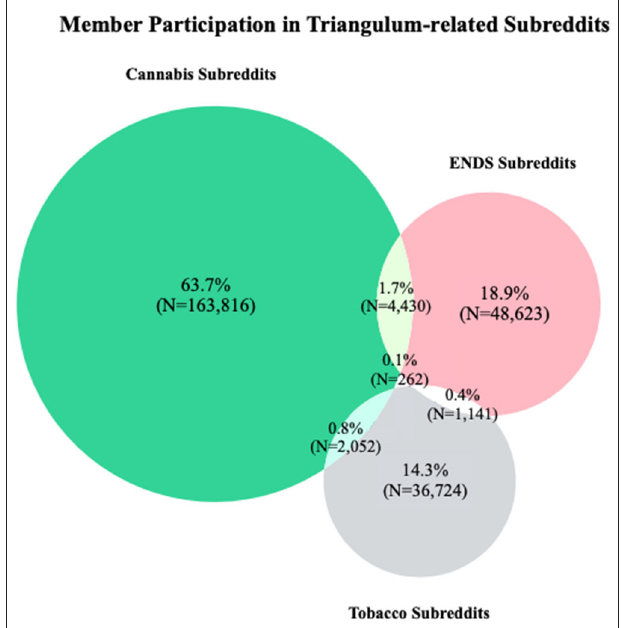
FIGURE 2 | Representation of the frequency of members posting in cannabis, tobacco, and ENDS-specific subreddits in our macro-corpus.